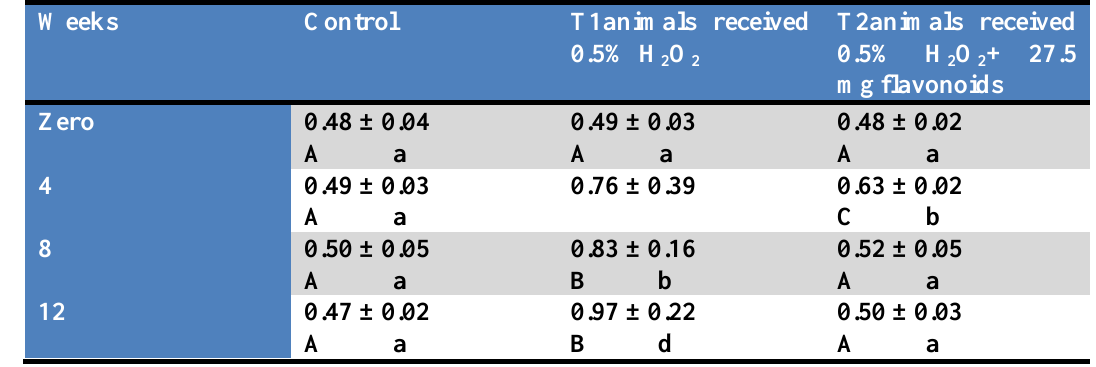
Table (5): Effect of flavonoids extracted from black cumin seed on serum malondiadehyde (MDA) concentration (mmol/ l) in control, H rabbit.